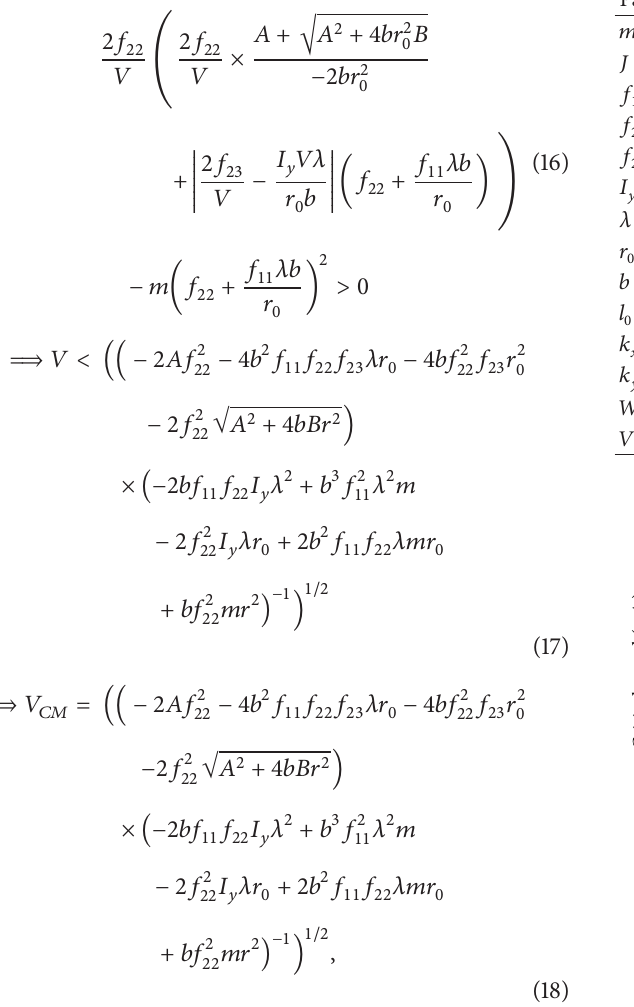
Figure 2: Influence of 𝑘 𝑥 on critical value 𝑉